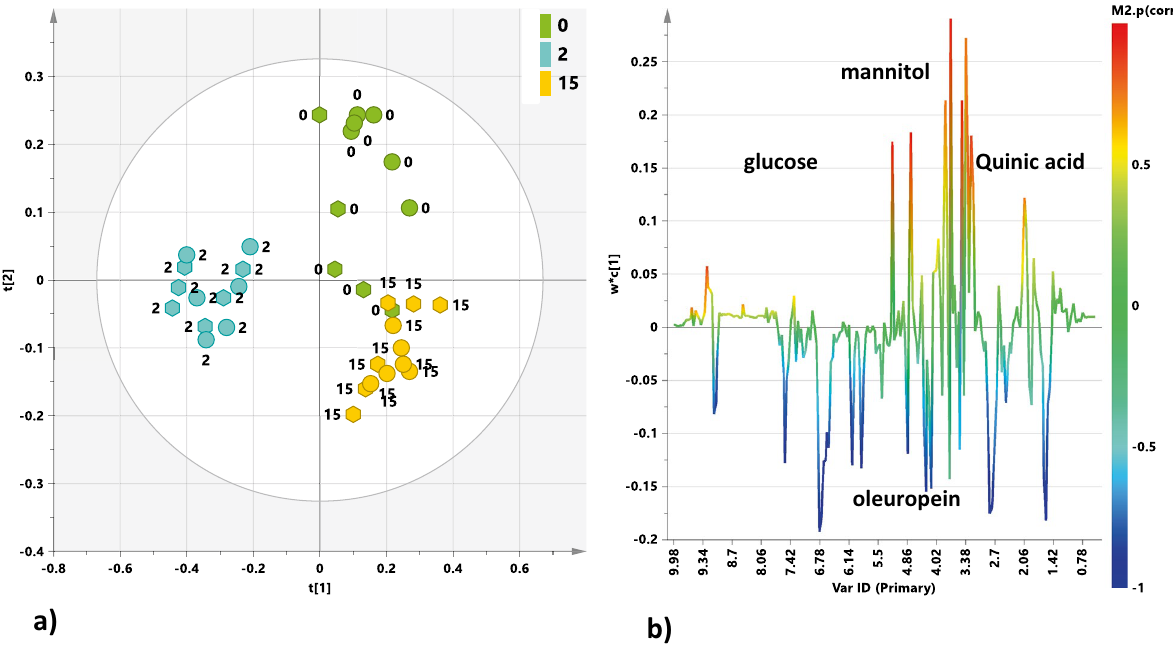
Figure 3. ( a ) PLS-DA t[1][2] scores plot (three components give R2X = 0.574, R2Y = 0.886; Q2 = 0.73) for leaf sample extracts from Ogliarola salentina (circles) and Cima di Melfi (hexagons) tree cultivars at day 0 (before injection), 2, and 15 after the injection. ( b ) Loading line plot for the model coloured according to the correlation-scaled loading (p(corr)